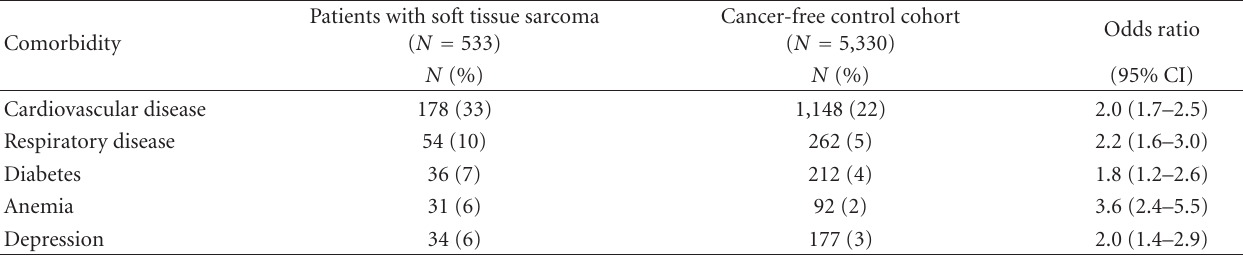
Table 2: Proportion of patients with comorbidities ∗ 12 months before diagnosis of soft tissue sarcoma, compared to a noncancer population.